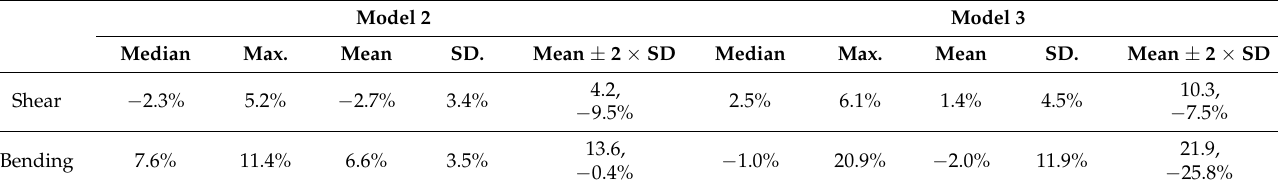
Table 11. Statistical data of difference in the shear/bending stresses calculated using TIRF with linear boundary conditions and DIR with nonlinear boundary conditions for Model 2 and Model